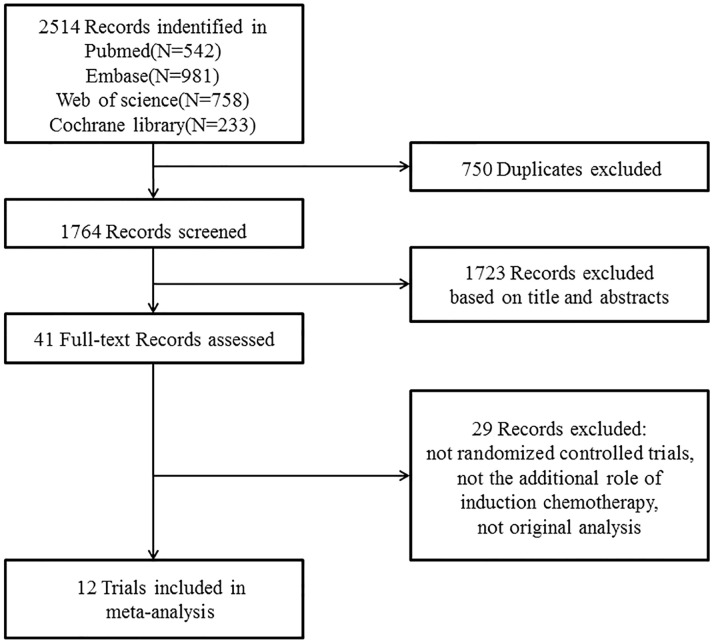
PRISMA flow diagram.